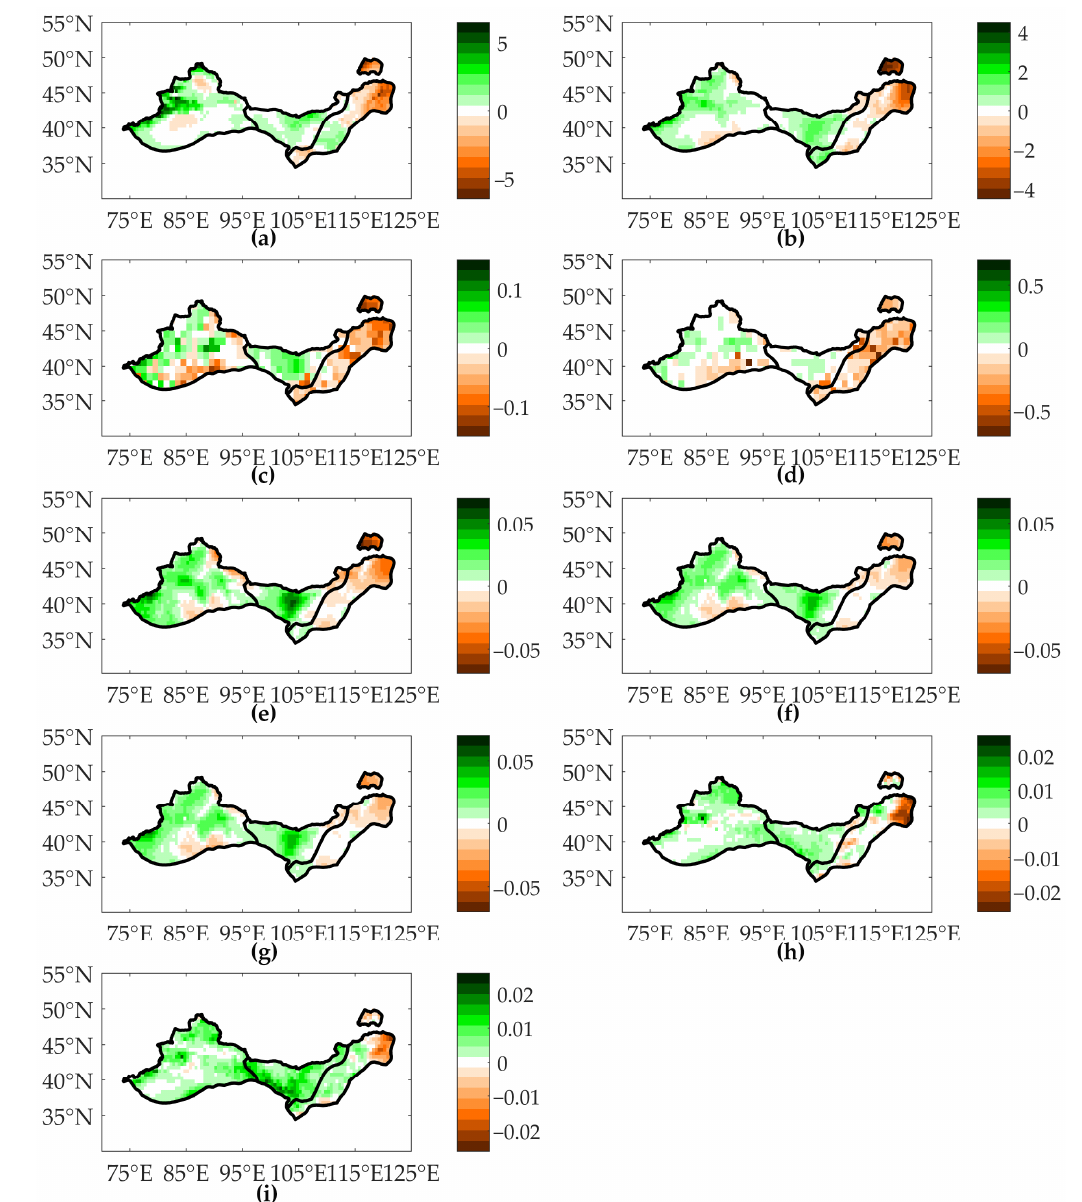
Figure 4. The spatial distribution of annual trends at the grid scale. ( a ) CMA_P (mm yr − 1 ); ( b ) CRU_P (mm yr − 1 ); ( c ) PDSI (yr − 1 ); ( d ) sc_PDSI (yr − 1 ); ( e ) SPEI-01 (yr − 1 ); ( f ) SPEI-06 (yr − 1 ); ( g ) SPEI-12 (yr − 1 ), ( h ) Root_sm (m 3 m − 3 yr − 1 ), ( i ) Surf_sm (m 3 m − 3 yr − 1 ) during 1982–2012. The solid lines indicate the